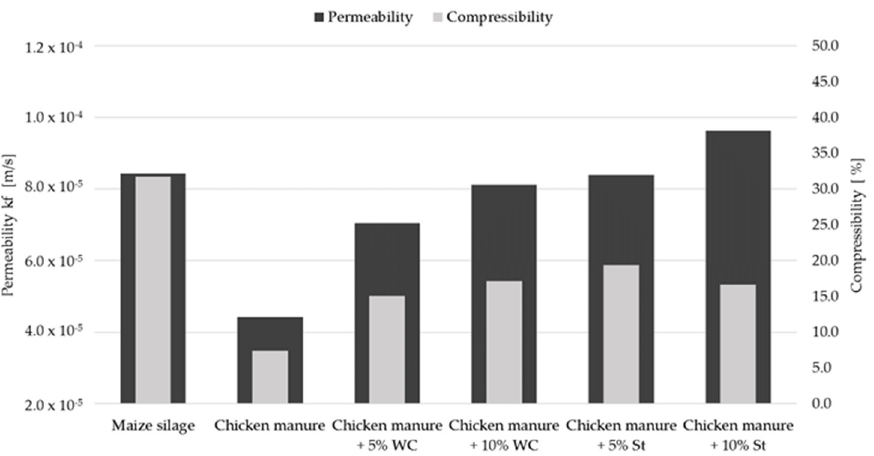
Figure 3. Permeability and compressibility characteristics of chicken manure with structure material addition relative to maize silage. WC, wood chips; St, straw.